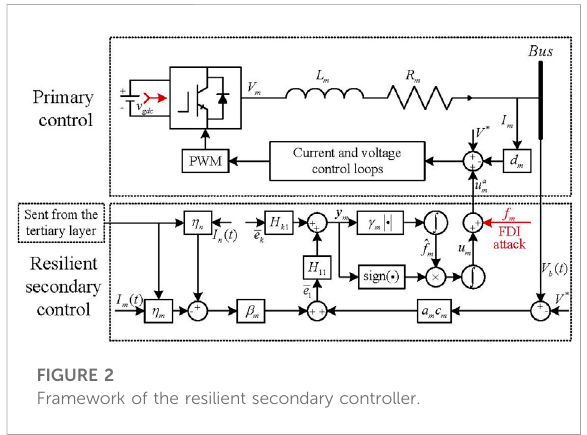
FIGURE 2 Framework of the resilient secondary